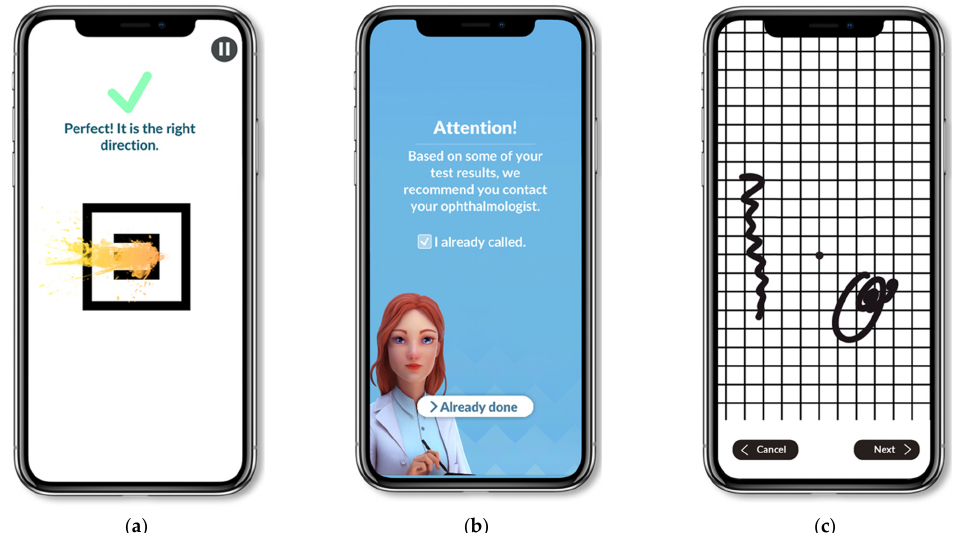
Figure 1. Images from the application: ( a ) VA test ; ( b ) message when an alert occurs; ( c ) Amsler grid.